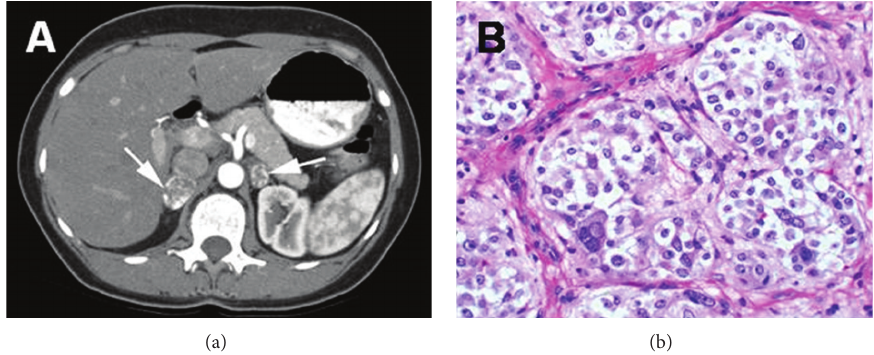
Figure 4: (a) Bilateral pheochromocytomas (arrows) with rim enhancement in the adrenal glands of a 26-year-old woman with VHL disease; (b) Pheocromocytomas tumor cells are arranged in rounded clusters, separated by endothelial-lined spaces, with have vesicles containing norepinephrine and epinephrine (Reprinted with permission from [51], Copyright Springer Verlag). VHL = Von Hippel −